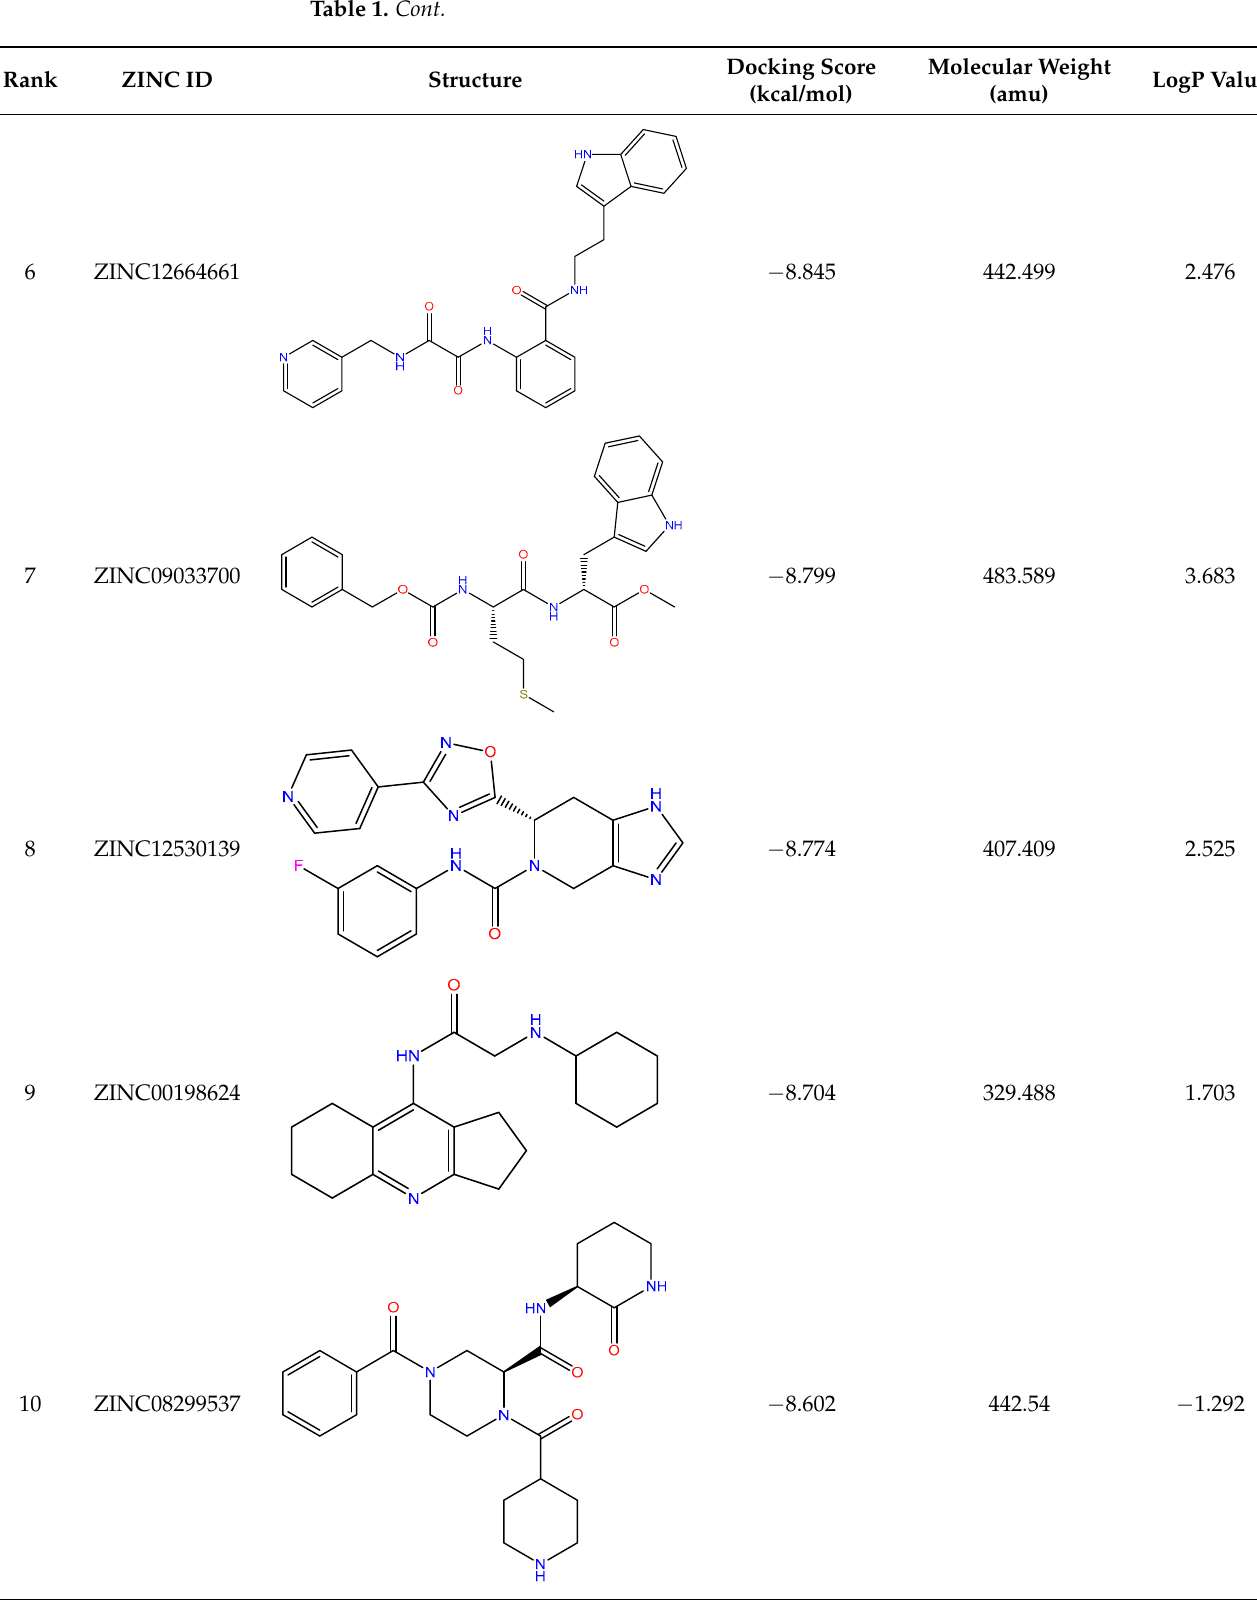
Table 2. MD binding free energy ranking of top 10 ligands with the highest docking